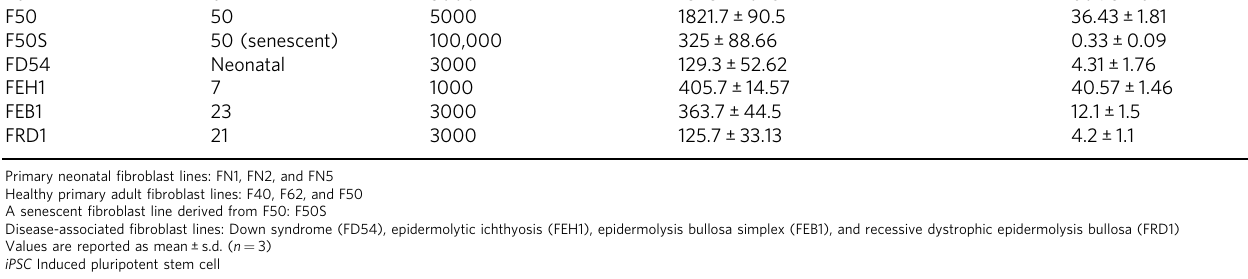
reprogramming) (FN2: Fig. 7a and Supplementary Fig. 15a; FN1: Supplementary Figs. 16a and 17a). This fi nding correlated with a